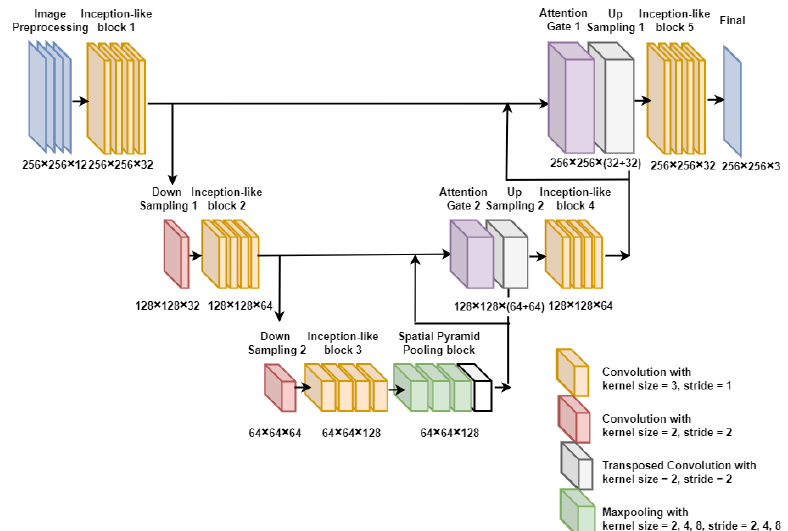
Figure 1. The proposed image-dehazing CNN architecture.